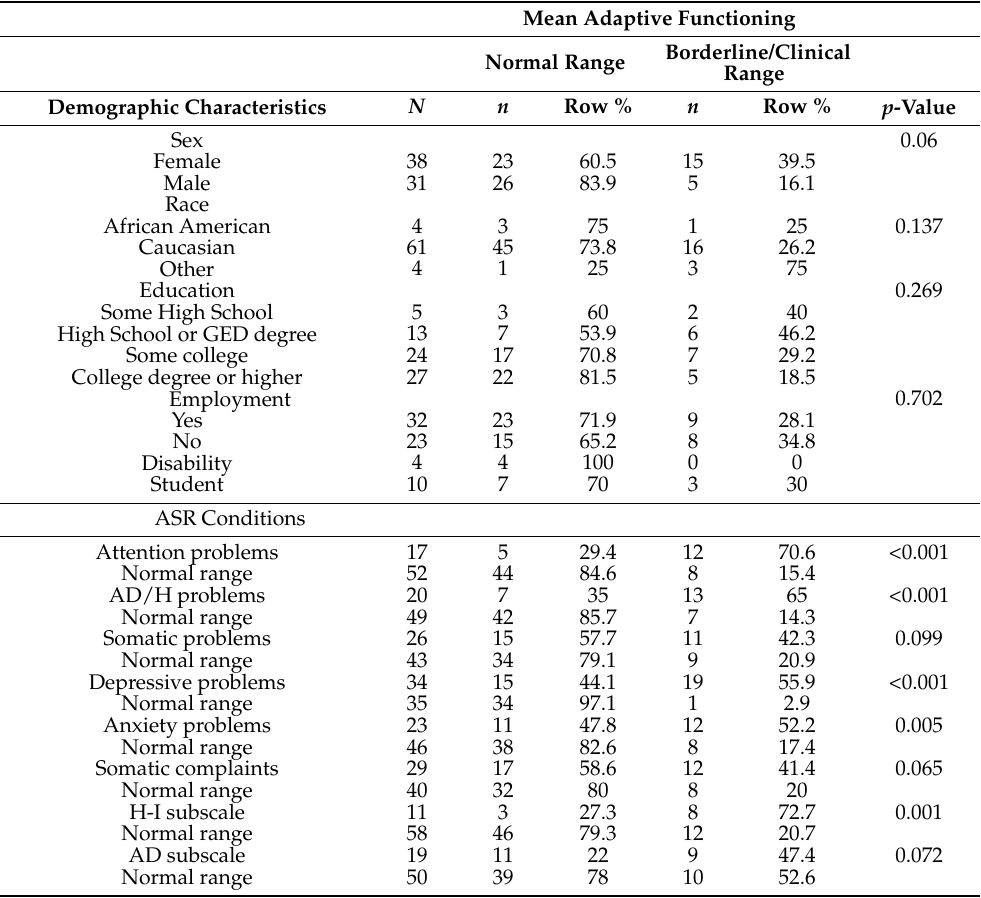
Table 4. Association between psychological symptoms and adaptive functioning in adults with FD when using the ASEBA Adult